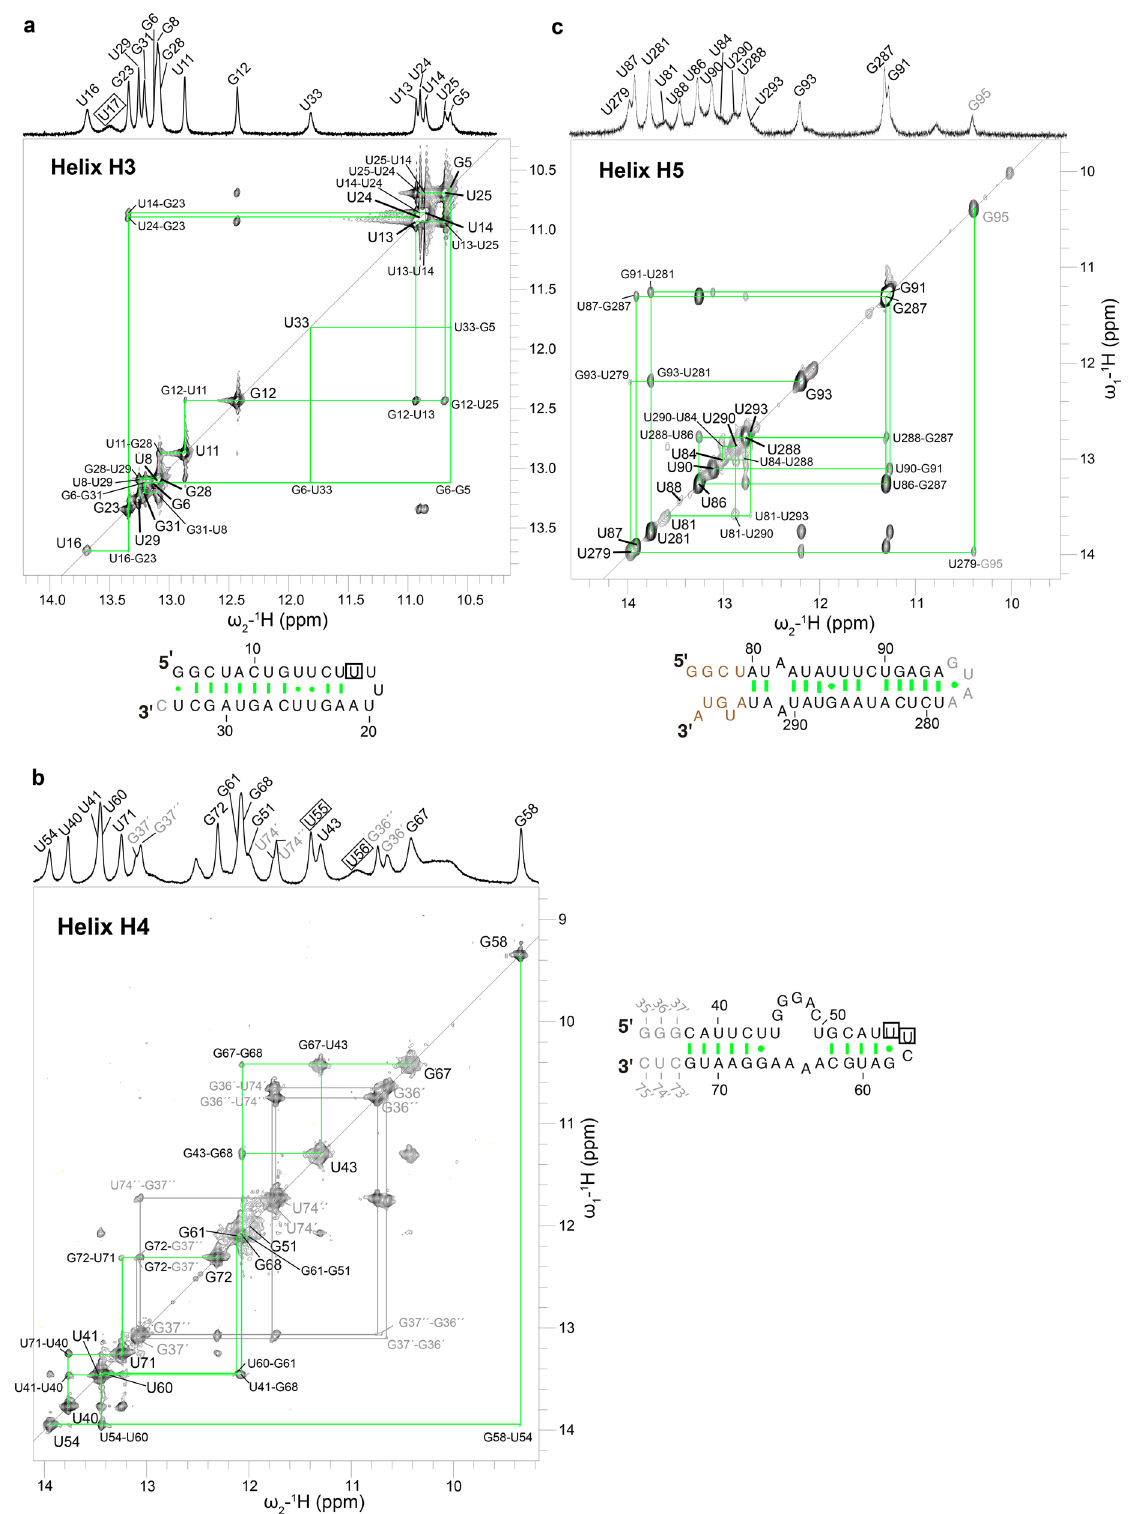
Fig. 3 Pf Alu RNA secondary structure. Imino regions of 1D and 2D 1 H, 1 H-NOESY spectra of helices H3, H4, and H5 are shown in a – c , respectively. RNA sequences of the corresponding helices are also shown. Nucleotides colored in gray have been added arti fi cially to the Alu RNA while those in brown could not be assigned. Wobble base pairs are connected by a dot while canonical Watson – Crick base pairs are connected by a hyphen. Resonances, which did not give imino cross-peaks to neighboring bases and were assigned by exclusion, are boxed. Helix H4 resonances exhibiting alternative conformations are numbered in